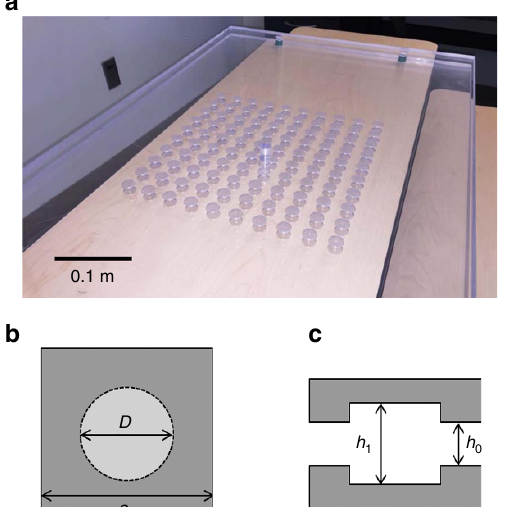
Figure 1 | Acoustic metamaterial with simultaneous zero effective mass density and infinite effective bulk modulus. ( a ) Photograph of the fabricated sample with square lattice of 10 (cid:3) 10 symmetric blind holes constituting an array of cylindrical scatterers. A through hole provides access to the centre of zero index metamaterial for a point source to excite the first order waveguide mode. Four spacers located at the corners of the sample ensure the height of the air channel in the waveguide and the alignments of the top and bottom plates. ( b , c ) Top and side views of a unit cell of the zero refractive index metamaterial, respectively. Grey areas mark the solid structures of the waveguide. The light grey circle in the top view denotes the blind holes on the top and bottom plates inside the waveguide. The top and bottom plates are symmetric about the central plane. D ¼ 16mm, h 0 ¼ 10mm, h 1 ¼ 14.5mm and a ¼